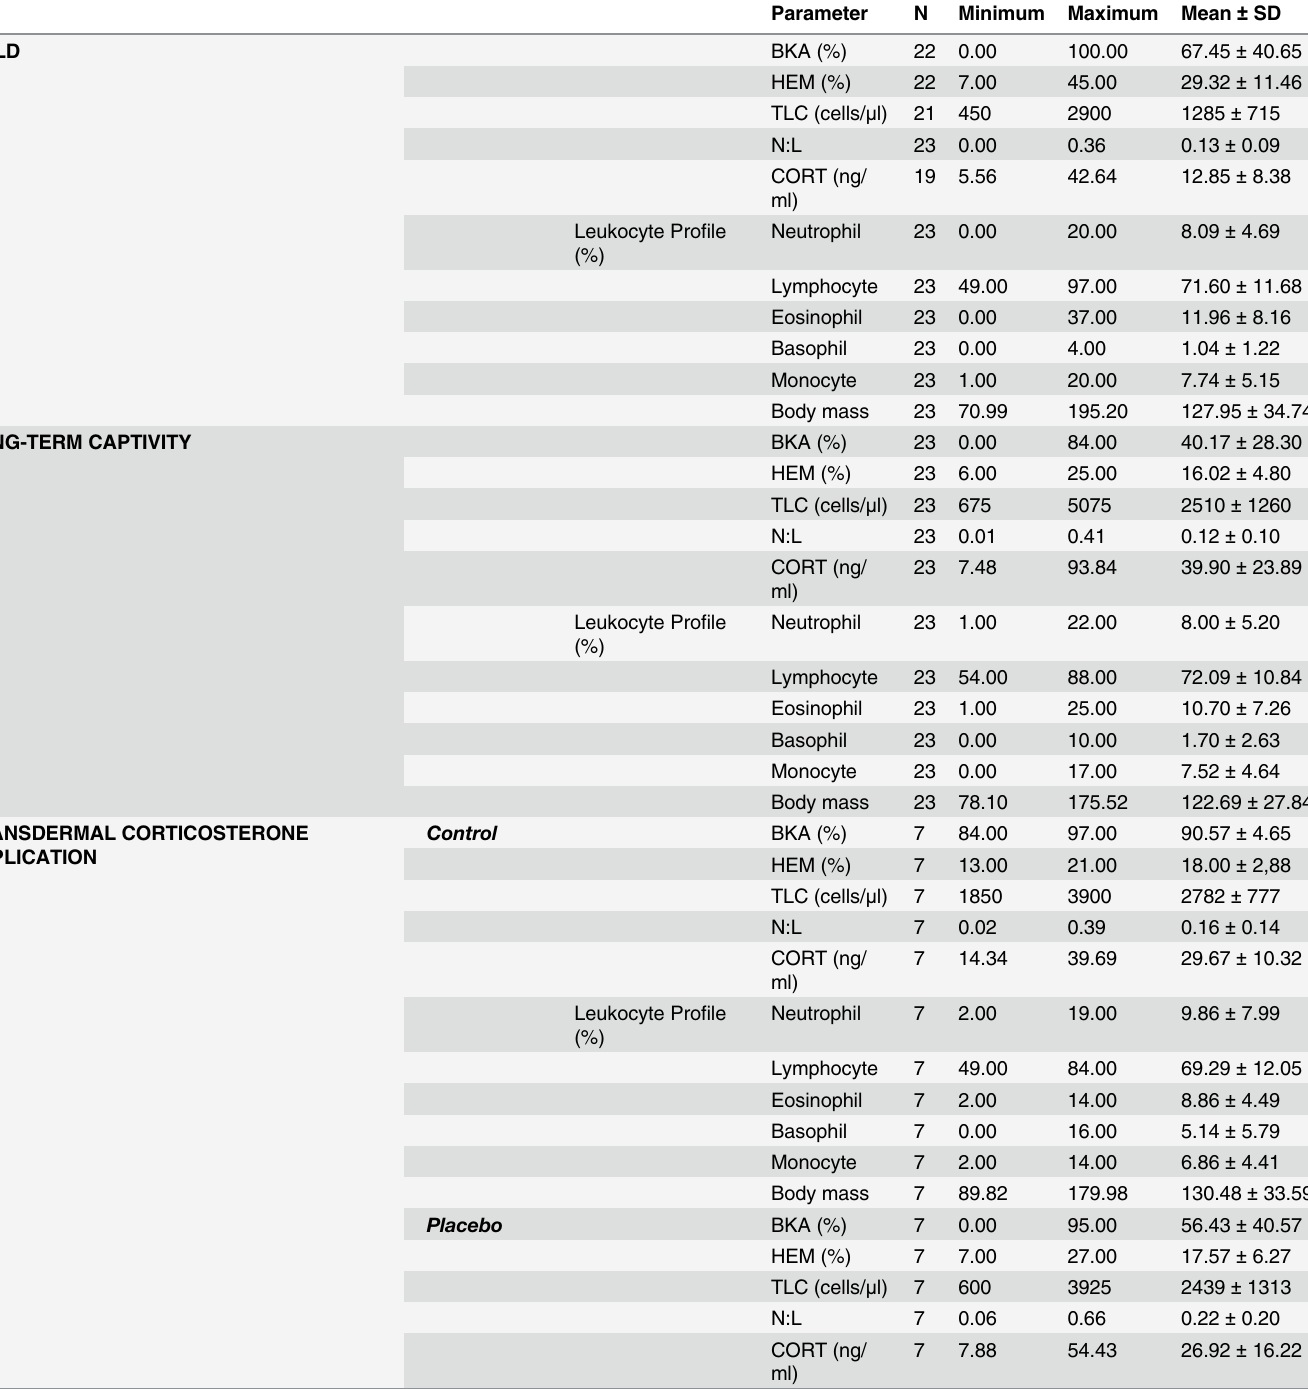
Table 1. Descriptive statistics of blood parameters and body mass for individuals of R . icterica under field conditions, after long-term captivity (three months), and at the end of the experiment of transdermal corticosterone application for 13